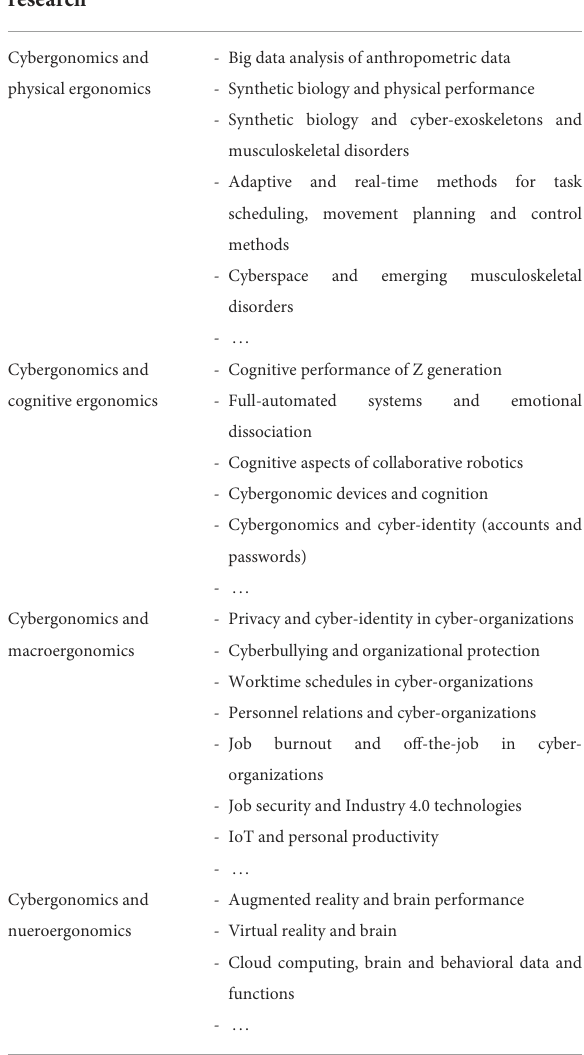
TABLE 3 Some possible joints and opportunities for research in